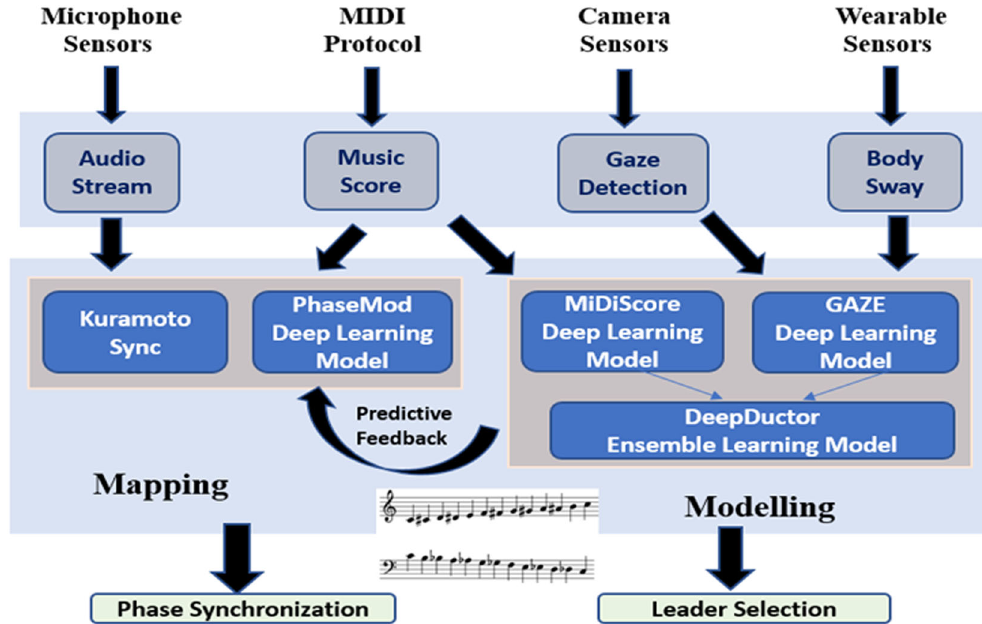
Fig. 2 System architecture and interaction fl ow between the modules of Cyborg Philharmonic. The proposed architecture showing the modules of Cyborg Philharmonic and their inter-play to achieve a synchrony for human – robot musical